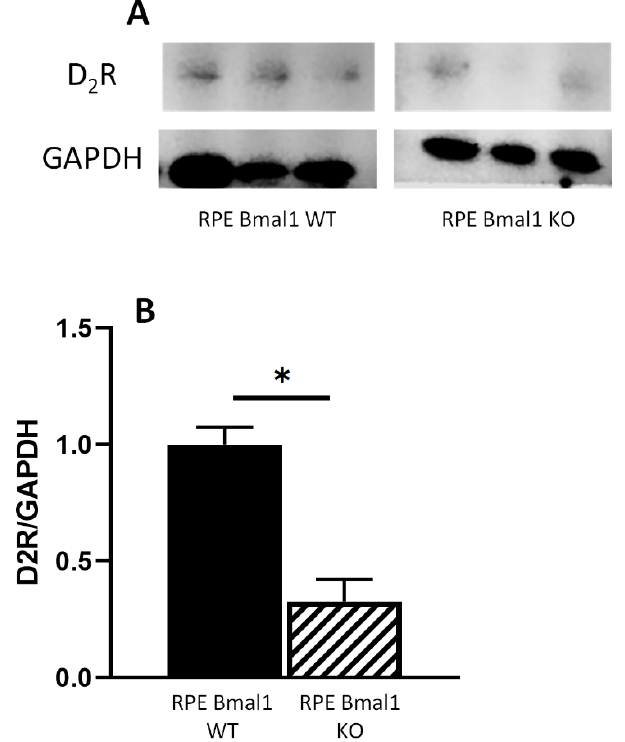
Figure 3. Dopamine 2 receptor protein is decreased in RPE Bmal1 KO mice. We previously identified that dopamine 2 receptor (D 2 R) played a role in mediating the peak in RPE phagocytic activity, leading us to examine the levels of D 2 R protein levels in RPE Bmal1 WT and RPE Bmal1 KO mice. RPE samples were collected at ZT1 (ZT0 at 7AM) and assessed via Western blot analysis. Representative Western blot bands for D 2 R and GAPDH antibodies ( A ). Densitometry analysis of the band intensities indicated a significant reduction in D 2 R protein in RPE Bmal1 KO mice when compared to RPE Bmal1 WT mice ( B ; * = p < 0.05, unpaired t -test, n = 3 mice/group). Data are expressed as mean ± SEM.